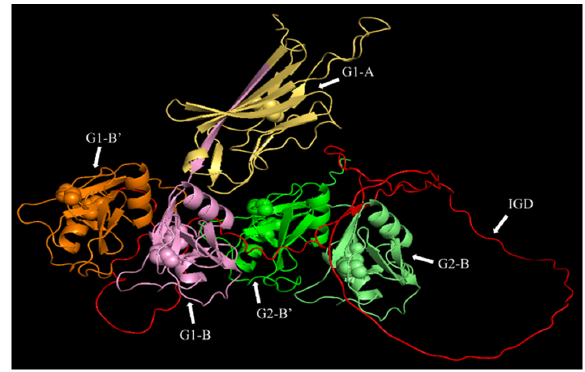
Figure 1. Computational-prediction of the three-dimensional structure of the G1-IGD-G2 domains of recombinant human aggrecan. The G1-A (yellow), G1-B (pink), G1-B’ (orange), interglobular domain (IGD, red), G2-B (light green), and G2-B’ (dark green) domains are indicated. The cysteine-derived disulfide bonds that stabilize the G1 and G2 domains are presented as spheres, with one present in G1-A, and two in each of other globular domains. Structure generated by using AlphaFold v2.2.3 software (London, UK) [48] by using the sequence from the UniProt database (entry P16112) and amino acids Val 20 -Gly 675